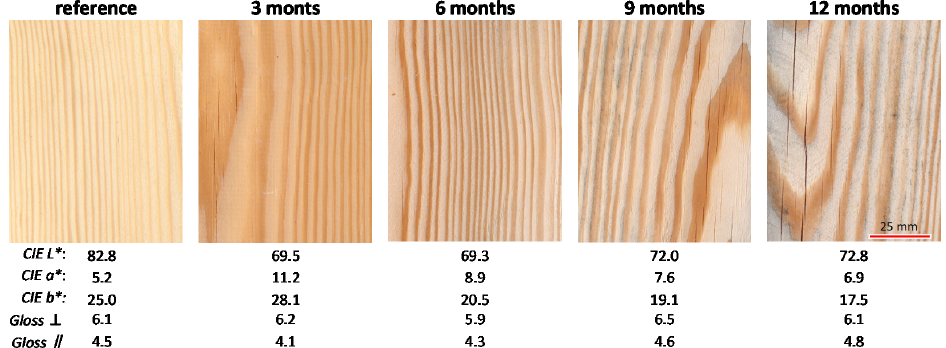
Figure 1. Surface texture, CIE L * a * b * colour coordinates and glossiness parameters altered during weathering progress of uncoated Scots pine